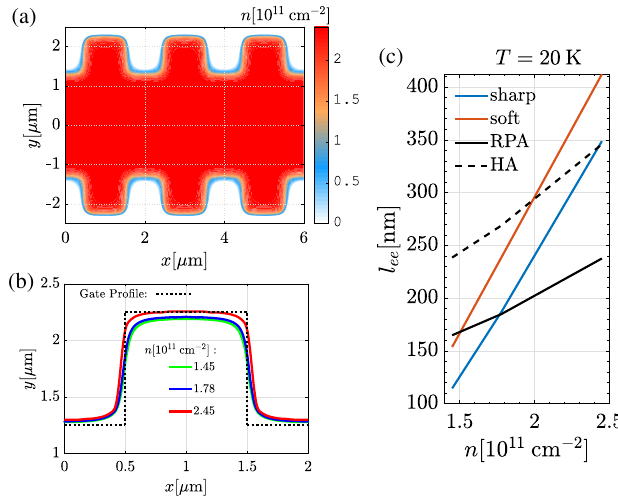
FIG. 9. (a) The charge contour plot over the plane of 2DEG for the highest gate voltage V ¼ 1 . 6 V, where the number density deep inside the channel (along y ¼ 0 ) is n ¼ 2 . 45 × 10 11 cm − 2 . (b) The electrical shape of the channel near the crenellation for three different densities, compared to the top gate marked by the dotted black line. The boundary of the channel is assumed to be the contour on which the density is half its maximum value. (c) The comparison of l at T ¼ 20 K extracted by assuming ee boundaries of the top gate and the softened boundaries in